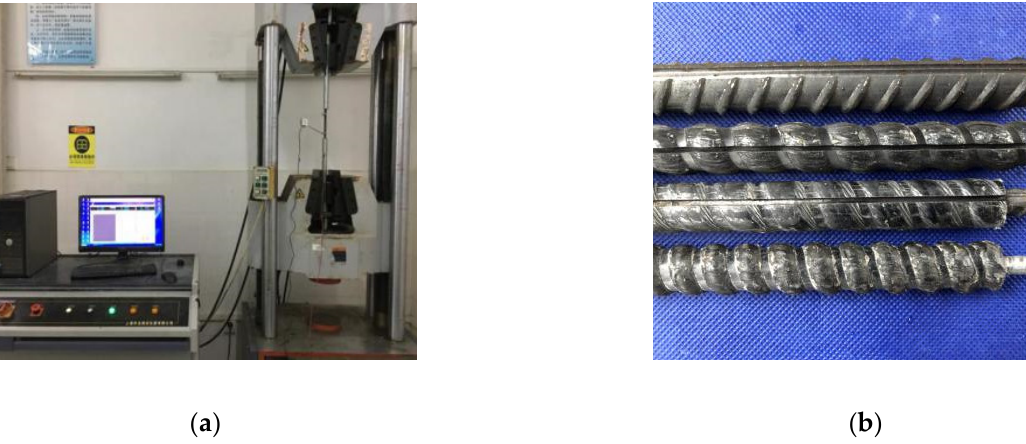
Figure 1. Experimental material and tensile test of reinforcement. ( a ) Tensile test of reinforcement ( b ) CFRP bars and SCFCB. Table 2. Mechanical properties of full coral concrete.